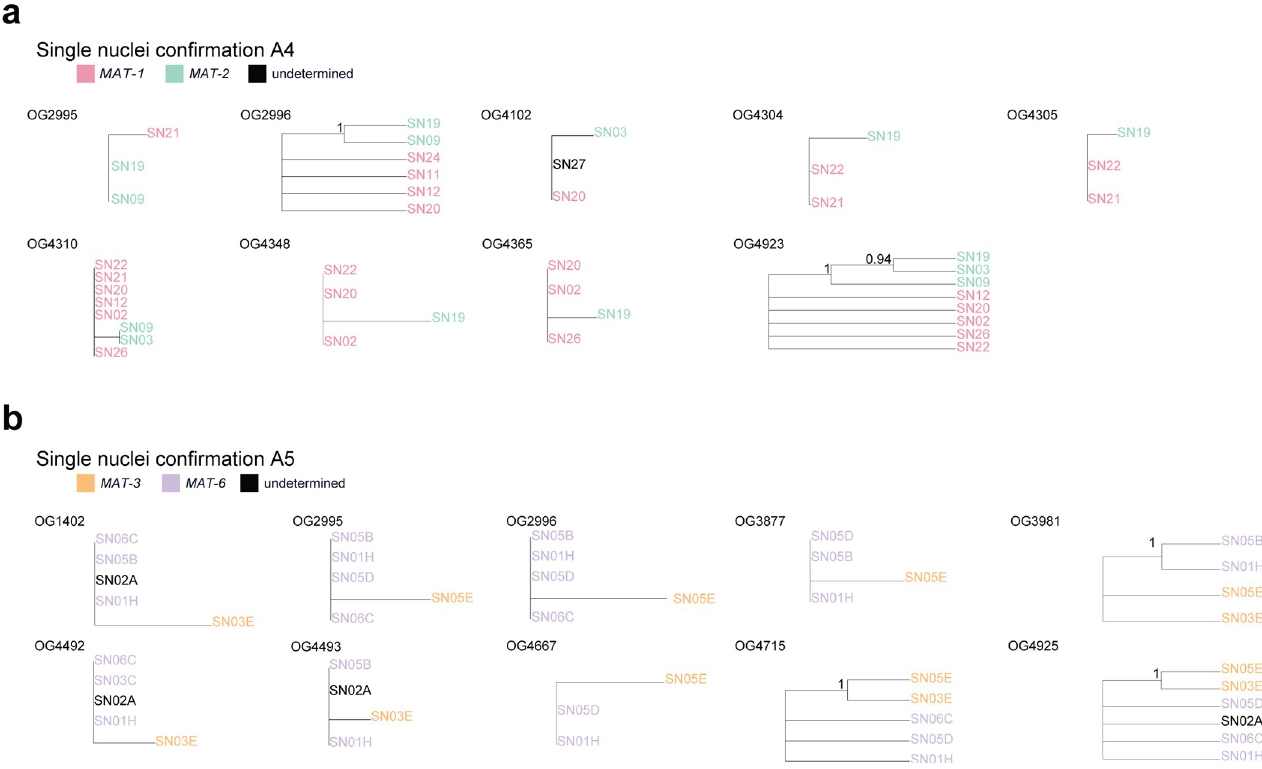
Fig 3. Single-nucleus sequence data confirms that genes contained in regions where a drop in coverage was observed are nucleotype-specific. Phylogenetic reconstruction of single-nucleus for genes found in regions where a drop in coverage was detected in A4 and A5 isolates. The genes are named by their membership to the orthologous groups previously defined. Branch support consisting of 100 bootstraps is shown. When only sequences from three nuclei were included, we performed an UPGMA hierarchical clustering. a, data for nuclei from A4 isolate. b, data for nuclei from A5